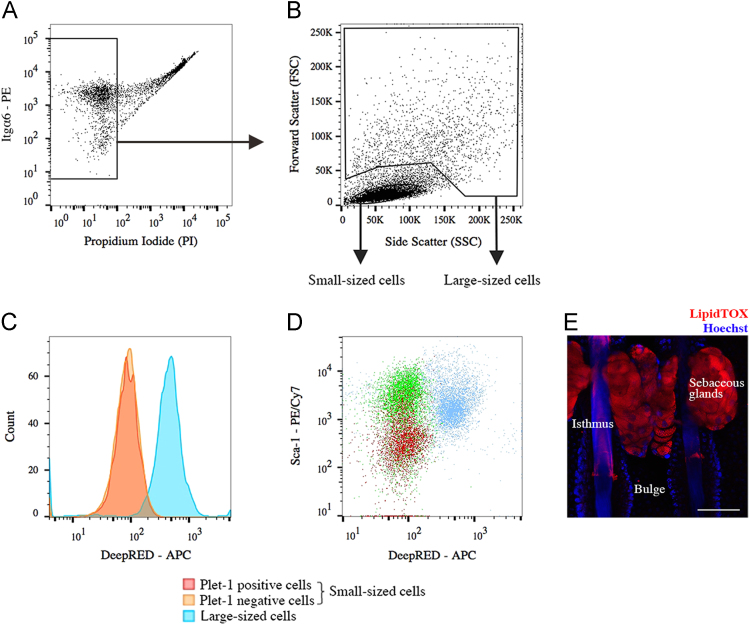
Using flow cytometry, the keratinocytes are first gated on viability and small size for subsequent isolation of the different epidermal populations. To verify that these were not differentiated cells of the sebaceous glands, keratinocyte cell suspension from dorsal skin was stained against Plet-1, Sca-1, Itgα6 and CD34 together with LipidTOX DeepRED that detects lipid droplets. (A) Cells are first selected for viability (negative for Propidium iodide). (B) Live cells are gated into small-sized (low forward- and side scatter) or large-sized (high forward- and side scatter). (C) Histogram illustrating DeepRED staining intensities of the large-sized cells and the small-sized cells, which were separated into Plet-1 positive and Plet-1 negative keratinocytes. (D) Dot plot of Plet-1 positive, Plet-1 negative and large-sized cells based on their Sca-1 and DeepRED intensities. (E) Confocal section view of two murine tail whole-mounts stained with LipidTOX DeepRED (red) and Hoechst (blue). Scale bar: 50 μm.(For interpretation of the references to color in this figure legend, the reader is referred to the web version of this article).